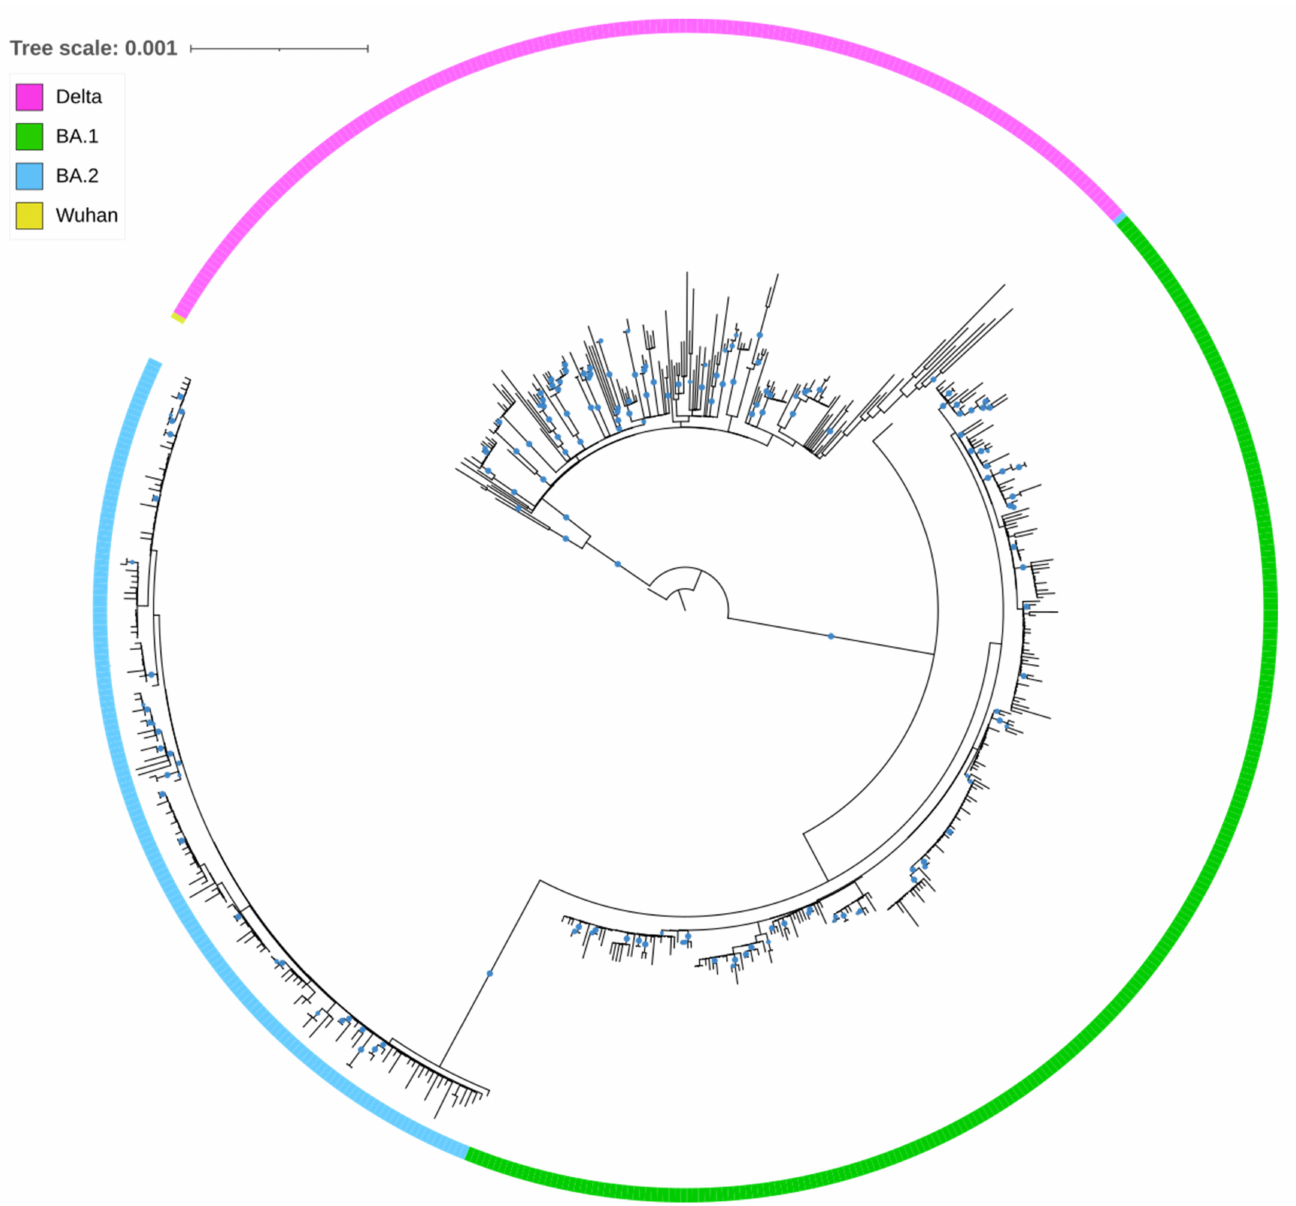
Figure 3. Phylogenetic tree of Cypriot full-genome sequences (n = 611) analyzed between November 2021 and April 2022 aligned against the reference genome hCoV-19/Wuhan/Hu-1/2019 (NC_045512.2). Bootstrap values >80% indicate the percentages of replicate trees, in which the associated taxa clustered together in the ultrafast bootstrap test (1000 replicates) are indicated by blue